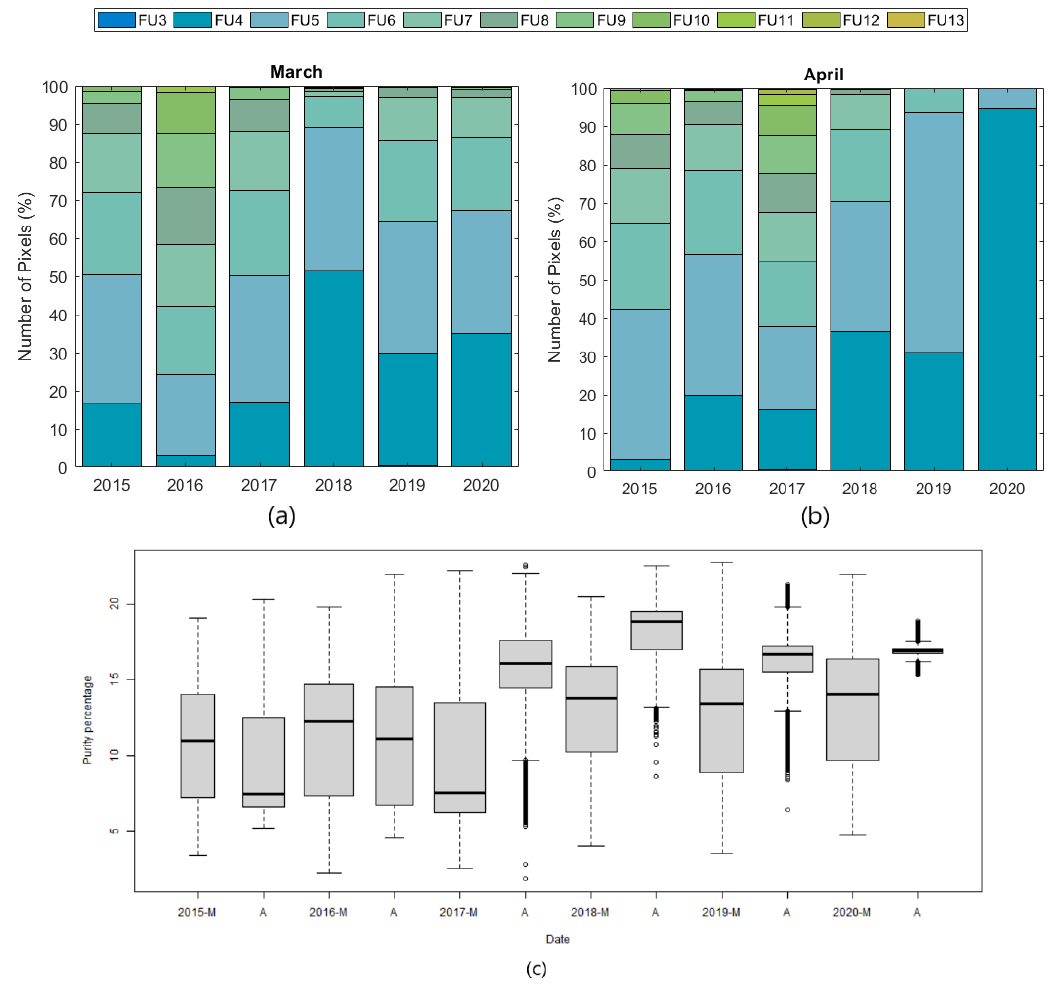
Figure 6. Comparison of FUI and Excitation purity for months March and April in years 2015 to 2019. ( a , b ) Stacked bar chart showing the FUI (number of pixels (%)) in March and April; ( c ) Box plot for excitation purity percentage (M: March, A: April) (gray box represents interquartile range, black line in the gray box shows median value, and black circles are